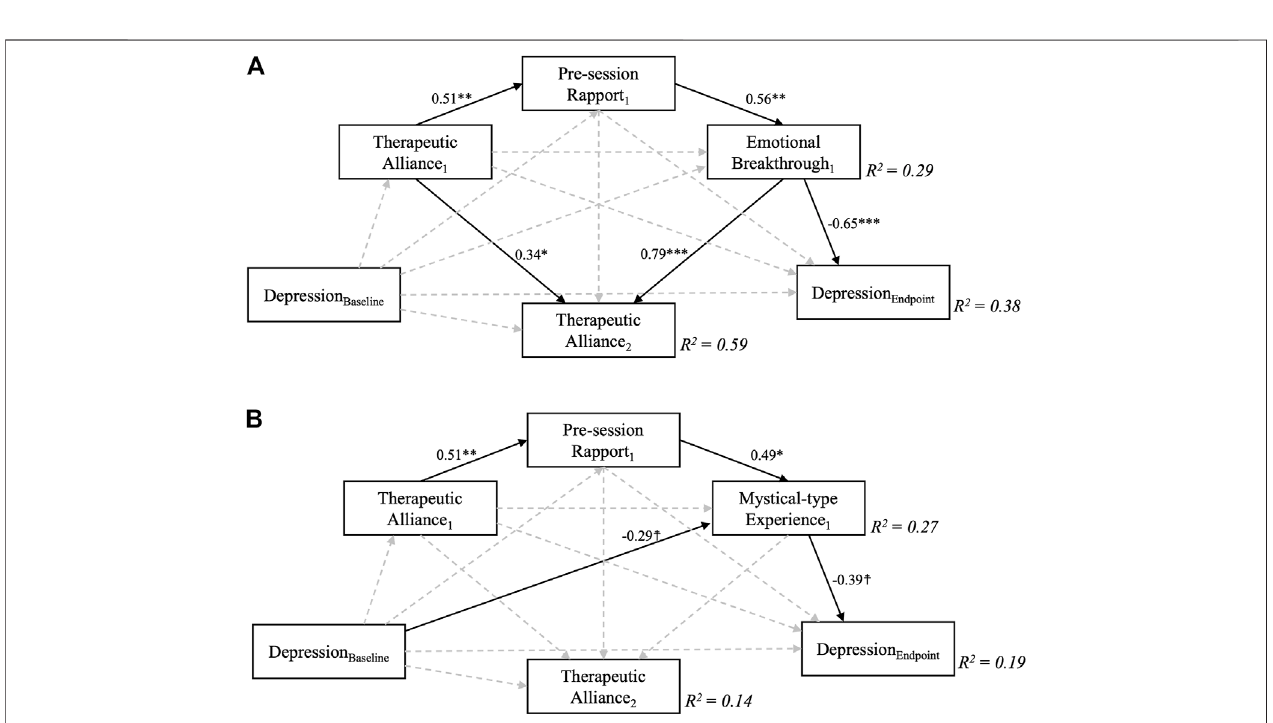
FIGURE 4| Near-saturated sequential mediation models exploring the relationship between therapeutic alliance during the fi rst psilocybin session and depression scores 6 weeks following a two-dose course of psychedelic-assisted psychotherapy. Sequential mediation of therapeutic alliance via pre-session rapport and A) EmotionalBreakthroughandB)Mystical-typeExperiencesweresupportedbythemodelsinthecaseofdepressionseverity,butnotforintermediate therapeuticalliance measured ahead of the second psilocybin session, which was only signi fi cantly predicted by Emotional Breakthrough scores. Depression severity at 6 weeks was controlled for baseline depression scores, which by itself accounted for R 2 = 0.12, i.e., 12% of variance in the fi nal outcome. MEQ, but not EBI scores were furthermore affected by baseline depression severity, although only at trend level. Numbers represent standardised regression coef fi cients for signi fi cant (solid, p > 0.1) but not non- signi fi cant (dashed) paths. Subscript numbers refer to the different psilocybin sessions, one and two; e.g., Therapeutic Alliance 1 refers to STAR-P scores ahead of psilocybin session one and Therapeutic Alliance 2 refers to STAR-P scores ahead of psilocybin session 2. ☨ indicates p < 0.1, * p < 0.05, ** p < 0.01, *** p < 0.001.